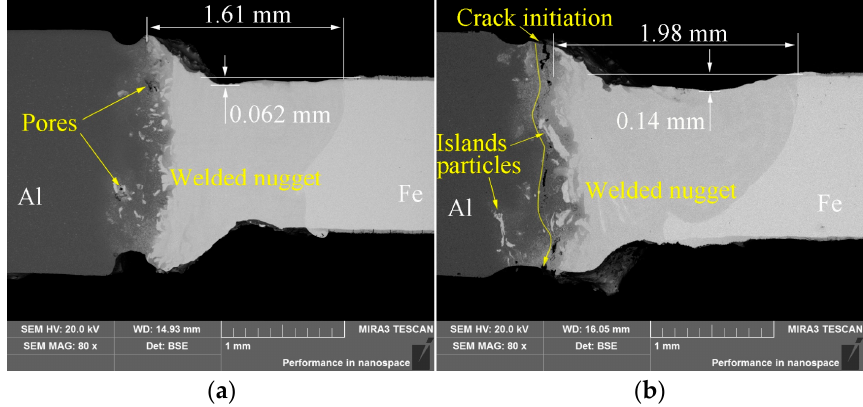
Figure 4. Cross-sectioned macrostructure of the welded joint with different thicknesses of the brass interlayer. ( a ) 0.05 mm and ( b ) 0.1 mm.